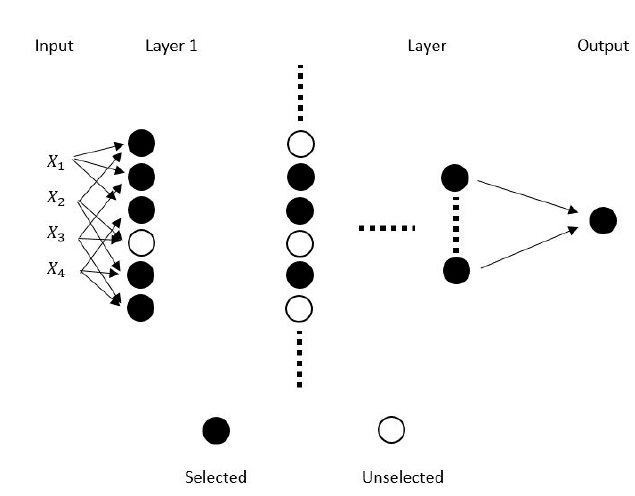
Figure 2. A proposed structure of the group method of data handling (GMDH) model.